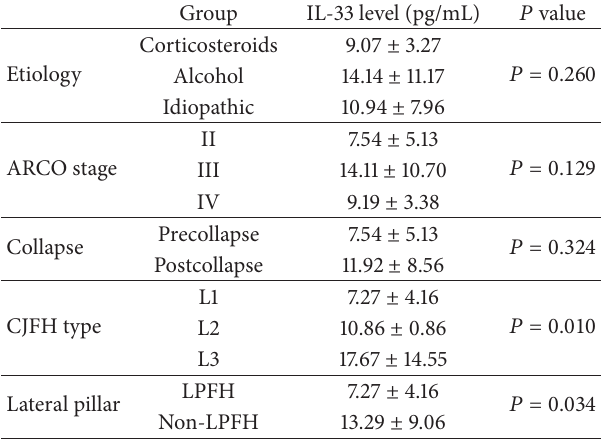
Table 3: Plasma IL-33 levels between different groups.